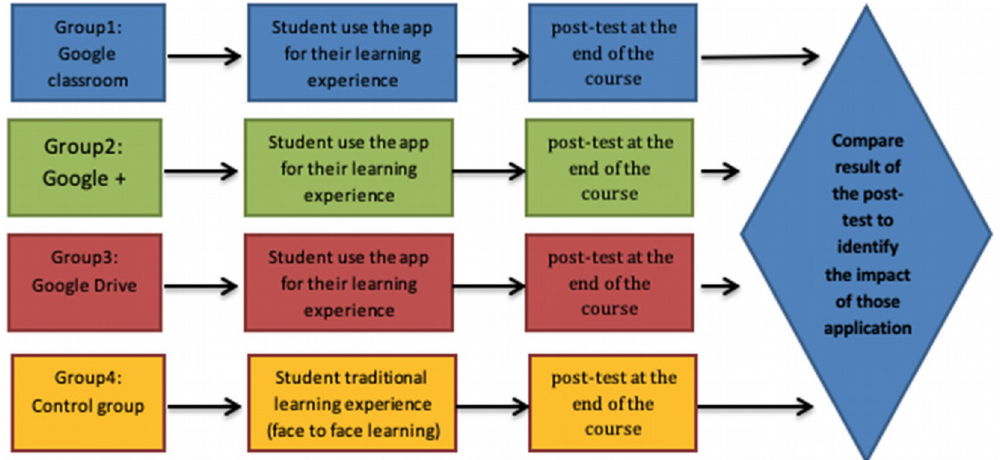
Figure 2. The process of identifying the impact of using Google Cloud applications